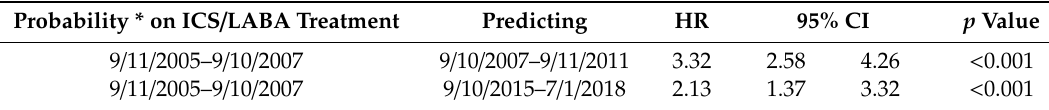
Table 3. Cox regression models for ICS / LABA treatment. Probability * on ICS / LABA Treatment